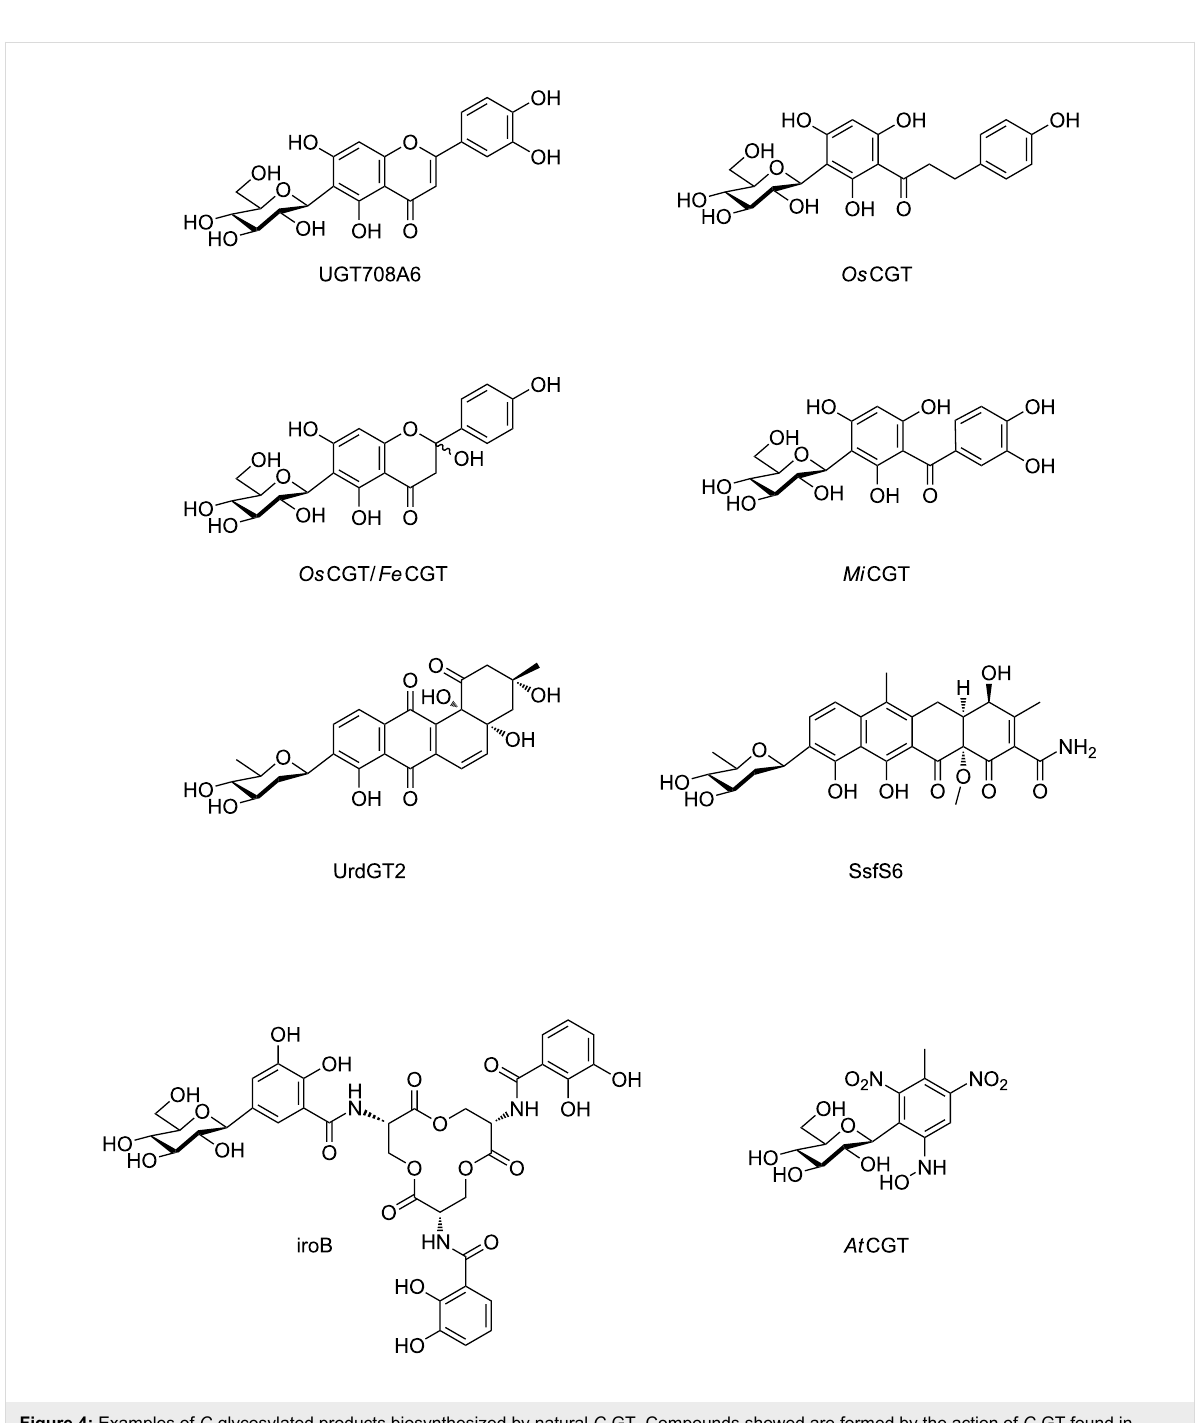
Figure 4: Examples of C -glycosylated products biosynthesized by natural C -GT. Compounds showed are formed by the action of C -GT found in maize (UGT708A6), rice ( Os CGT), buckwheat ( Fe CGT), Mangifera indica ( Mi CGT), Arabidopsis thaliana ( At CGT), fungi (UrdGT2 and SsfS6) or bacteria